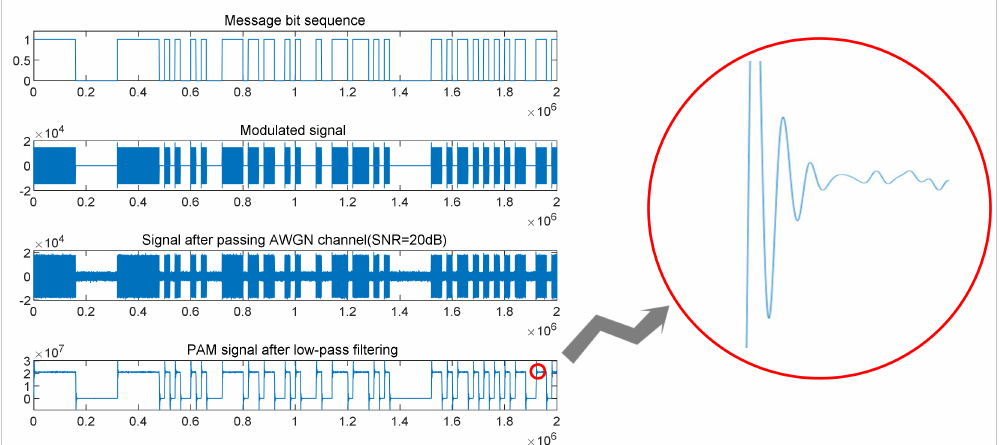
Figure 7. Signal simulation flowchart: entire signal process from original message bits to demodulation after passing through the channel; partial signal enlargement after low-pass filtering. Jitter reflects nonlinear characteristics of the power amplifier in the signal-amplification